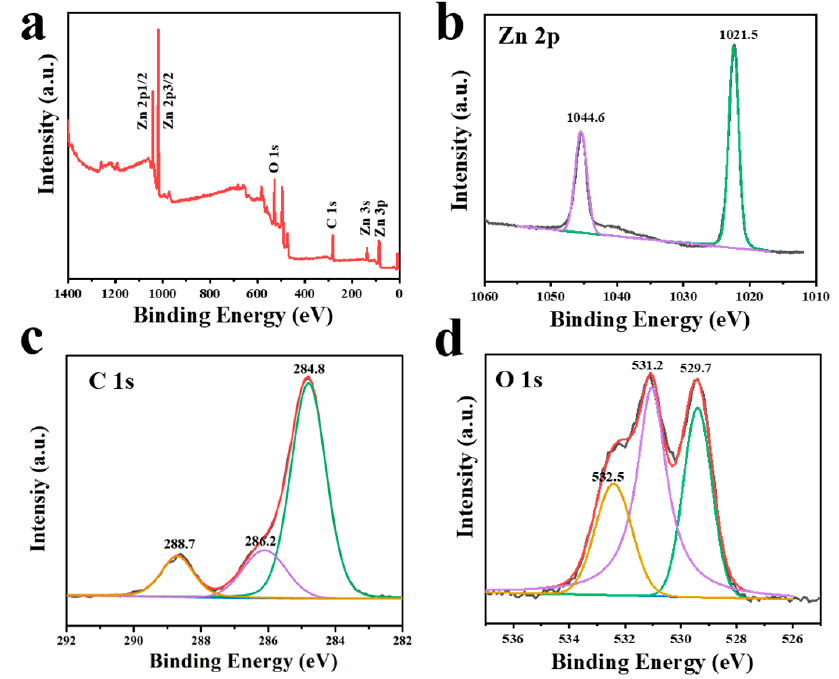
Figure 6. ( a ) Survey XPS spectrum of GO/ZnO nanosheet composites, and the corre-sponding elements’ high-resolution XPS spectra: ( b ) Zn 2p, the purple line corresponds to Zn 2p1/2 and the green line corresponds to 2p3/2, respectively, ( c ) C 1s, the green, purple and yellow line correspond to functional groups C-C, C-O and C-COOH, respectively, ( d ) O 1s, the green, purple and yellow line correspond to O-Zn bonding, oxygen vacancies and defects, and chemisorbed oxygen species, respectively.